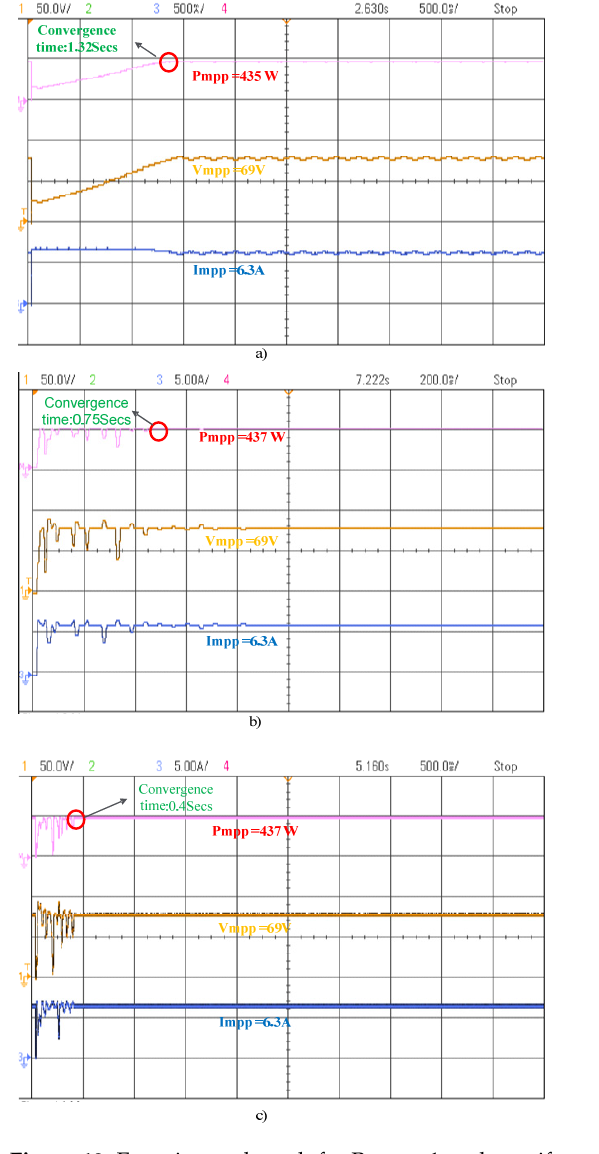
Figure 19. Experimental result for Pattern 1 under uniform shading ( a ) P&O, ( b ) PSO, ( c ) SHO.